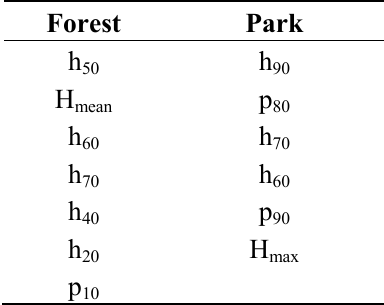
Table 4. Selected predictor variables for both parts of the study area in order of the predictor importance.